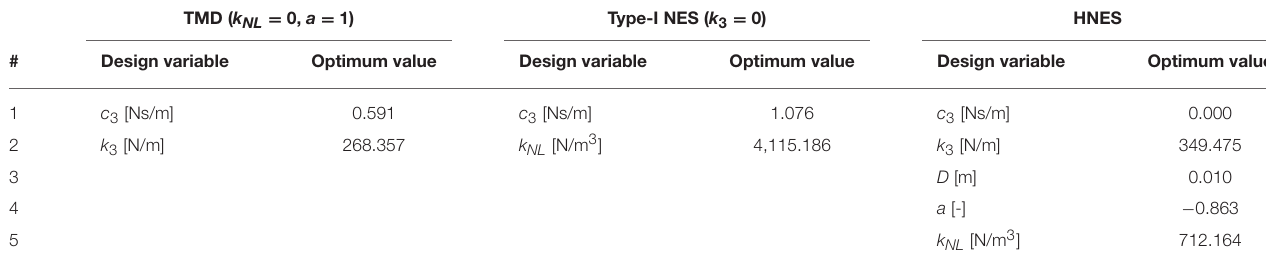
TABLE 3 | Optimum parameter values for the TMD, NES, and HNES